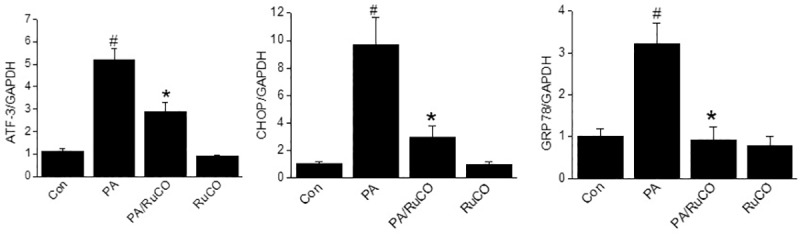
Effects of RuCO (a CO donor) on PA-mediated lipotoxicity.INS-1 cells were treated with RuCO (150 μM) for 1 h and then incubated with PA (500 μM) for 8 h. The mRNA expression levels of ER stress markers were detected by qPCR. The results shown are representative of three independent experiments and are expressed as means ± SDs. #P<0.05 vs. controls; *P<0.05 vs PA alone.